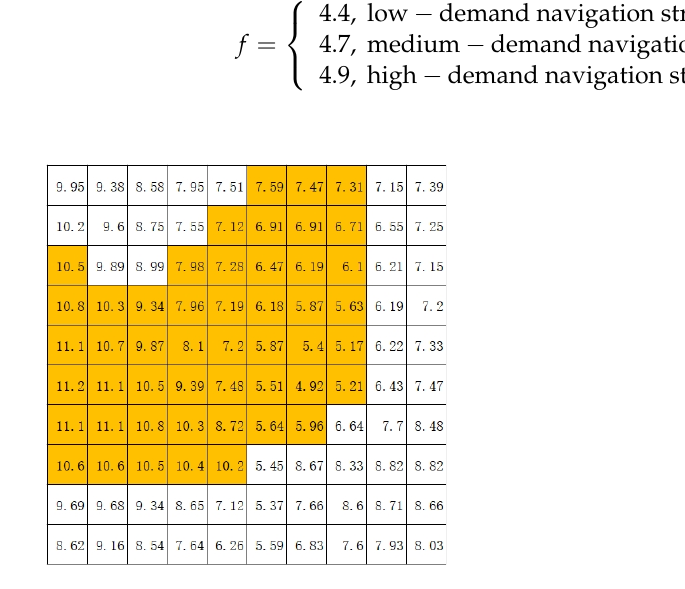
Figure 5. The result of company A.